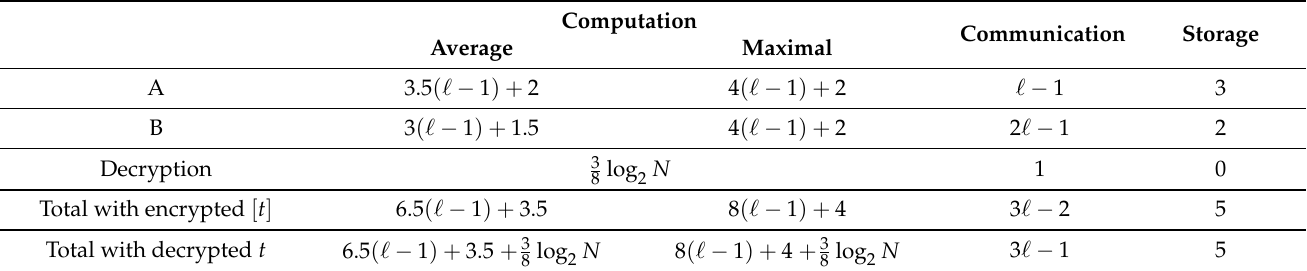
Table 3. Complexity